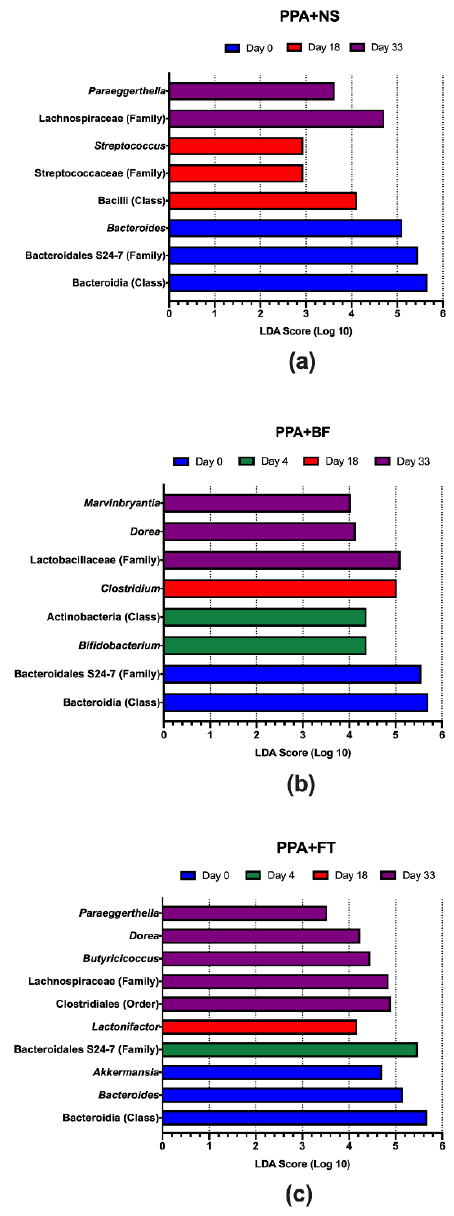
Figure 6. Linear discriminant analysis (LDA) effect size (LEfSe) of gut microbiota in different treatments. Relative abundance of gut microbiota was compared within the propionic acid (PPA + NS) group ( a ), the Bifidobacterium (PPA + BF) treatment group ( b ), and fecal microbiota transplantation (PPA + FT) treatment group ( c ). Only taxa with statistically significant differences ( p ≤ 0.05) are presented. NS, normal saline.